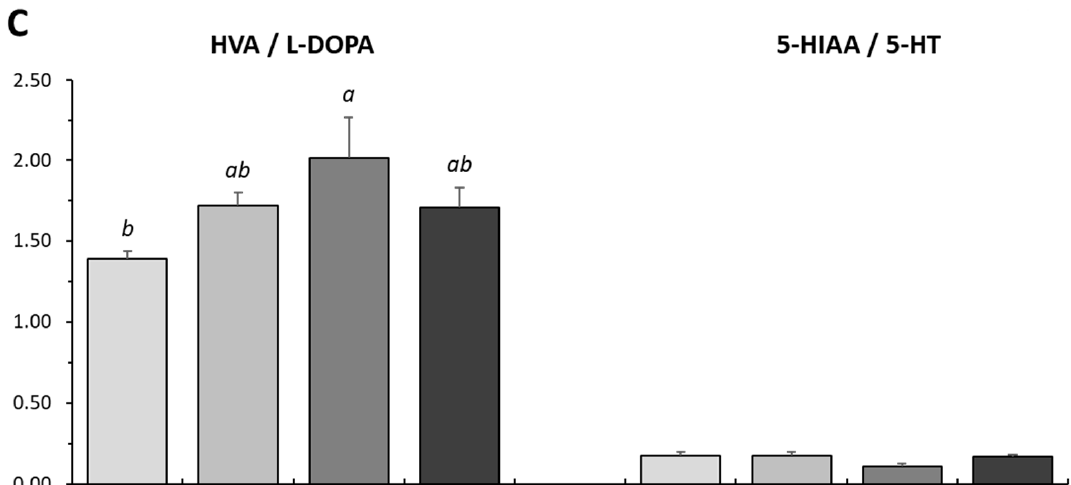
Figure 4. Brain concentrations of ( A ) catecholamines (L-DOPA, HVA), ( B ) indolamines (5-HT, 5-HIAA) and ( C ) corresponding monoamines pathway ratios HVA/L-DOPA and 5-HT/5HIAA in whole brain of rainbow trout hand-fed during 12 weeks with different stocking densities. Values are expressed as group mean ± SEM; one-way ANOVA, followed by a post hoc Tukey’s test in case of significant differences ( p < 0.05, indicated with different letters. Mean values that do no share a common letter are significantly different).